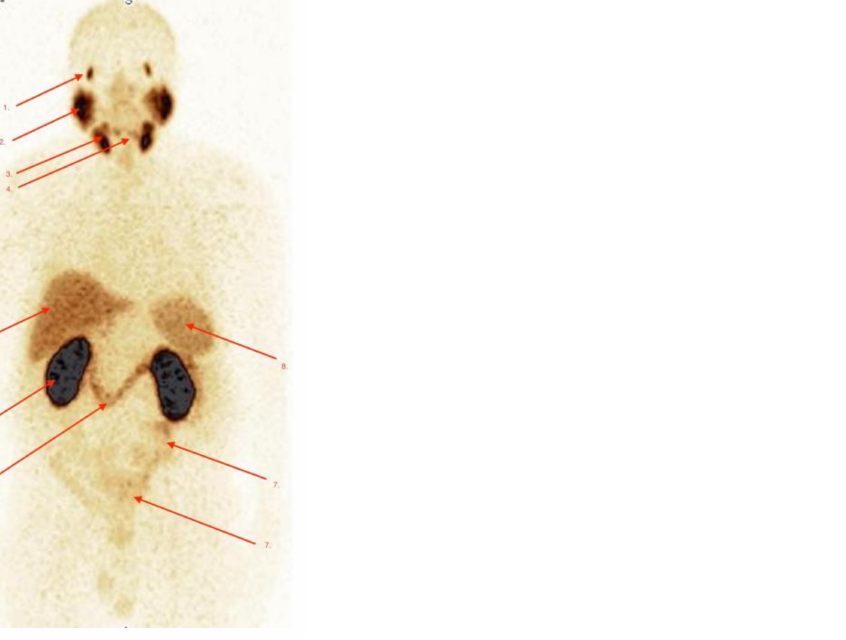
Figure 2. Physiological biodistribution of [ 99m Tc]Tc-PSMA-T4 in patient without active pathology due to PCa. The physiological uptake of radio-tracer is seen in the coronal view of the WB-SPECT- scan (MIP-Multi-Image-Projections), 5h after i.v. injection of 459MBq of [ 99m Tc]Tc-PSMA-T4. The very high uptake of radiotracer is seen in lacrimal glands (1), parotid and submandibular glands (2) and (3), and in the present case, also in additional submandibular glands (4), and additional high physiological uptake of radio-tracer is seen in both kidneys (6). Less intensive physiological uptake of radiopharmaceutical is also seen in the liver (5), large bowel (7) and spleen